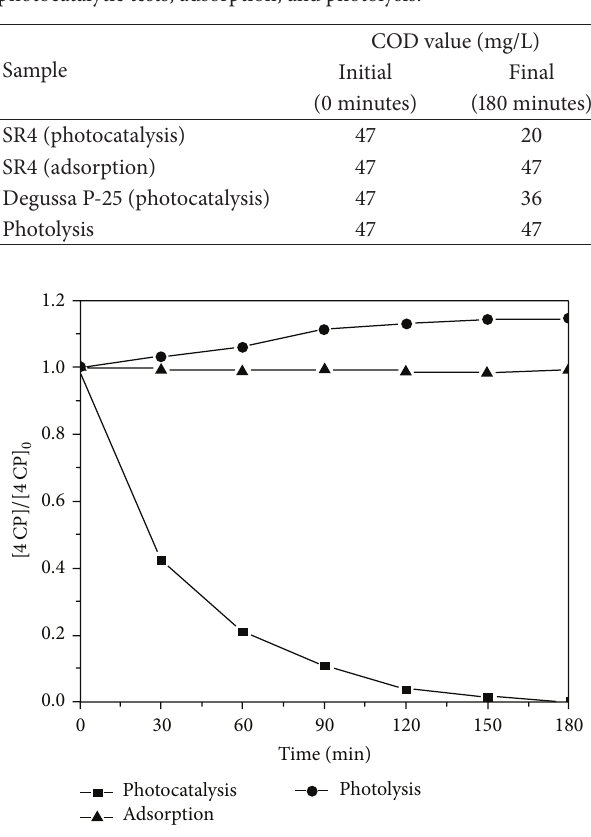
Figure 7: Effect of photocatalysis, adsorption, and photolysis on the removal of 4CP as a function of time using mesoporous titania sample SR4.